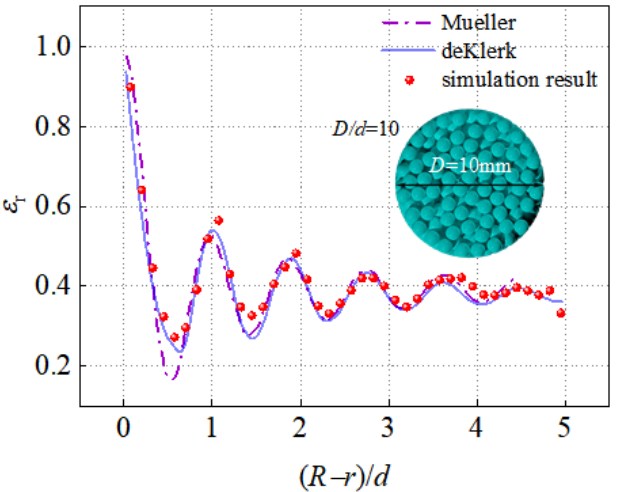
Figure 7. Comparison of radial porosity distribution resulting from the DEM model and de Klerk equation.